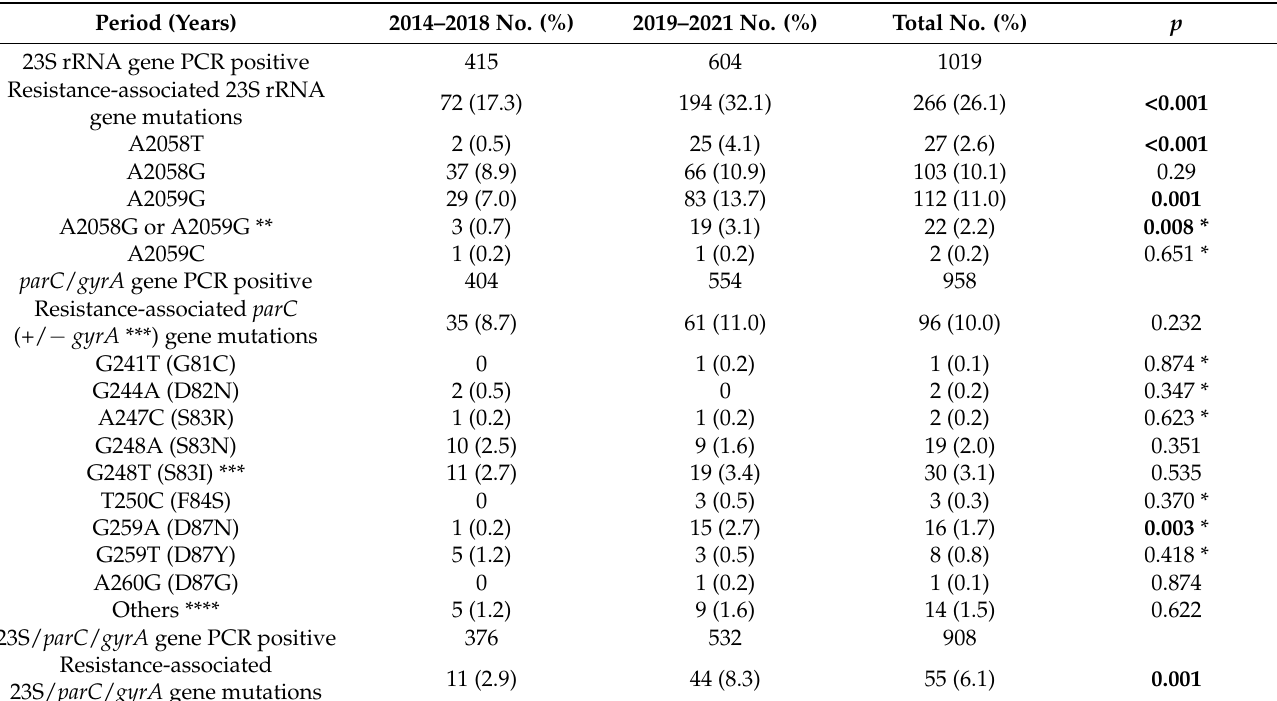
Table 1. Comparison of rates of resistance to macrolides (23S rRNA gene) and fluoroquinolones ( parC and gyrA genes) in 1019 episodes of infection by Mycoplasma genitalium in Gipuzkoa